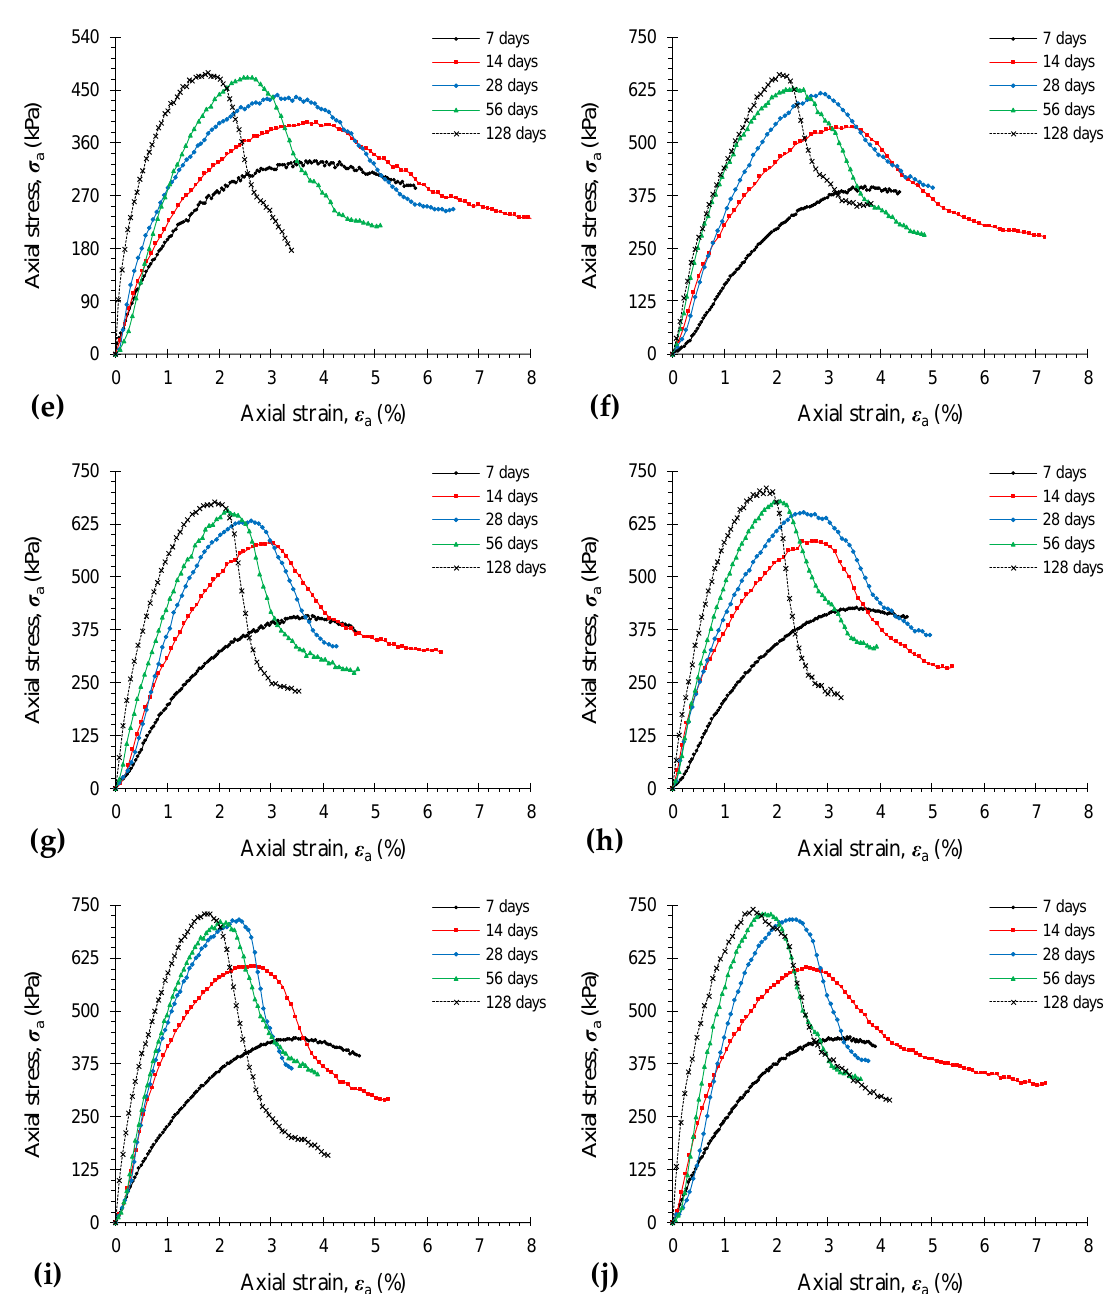
Figure A2. UC stress–strain curves for various MC + FA-treated mixtures: ( a ) M 1.5 F 0.5 T z ; ( b ) M 1.5 F 1.0 T z ; ( c ) M 1.5 F 1.5 T z ; ( d ) M 1.5 F 2.0 T z ; ( e ) M 1.5 F 2.5 T z ; ( f ) M 2.5 F 0.5 T z ; ( g ) M 2.5 F 1.0 T z ; ( h ) M 2.5 F 1.5 T z ; ( i ) M 2.5 F 2.0 T z ; ( j ) M 2.5 F 2.5 T z ( z = {7, 14, 28, 56, 128}).